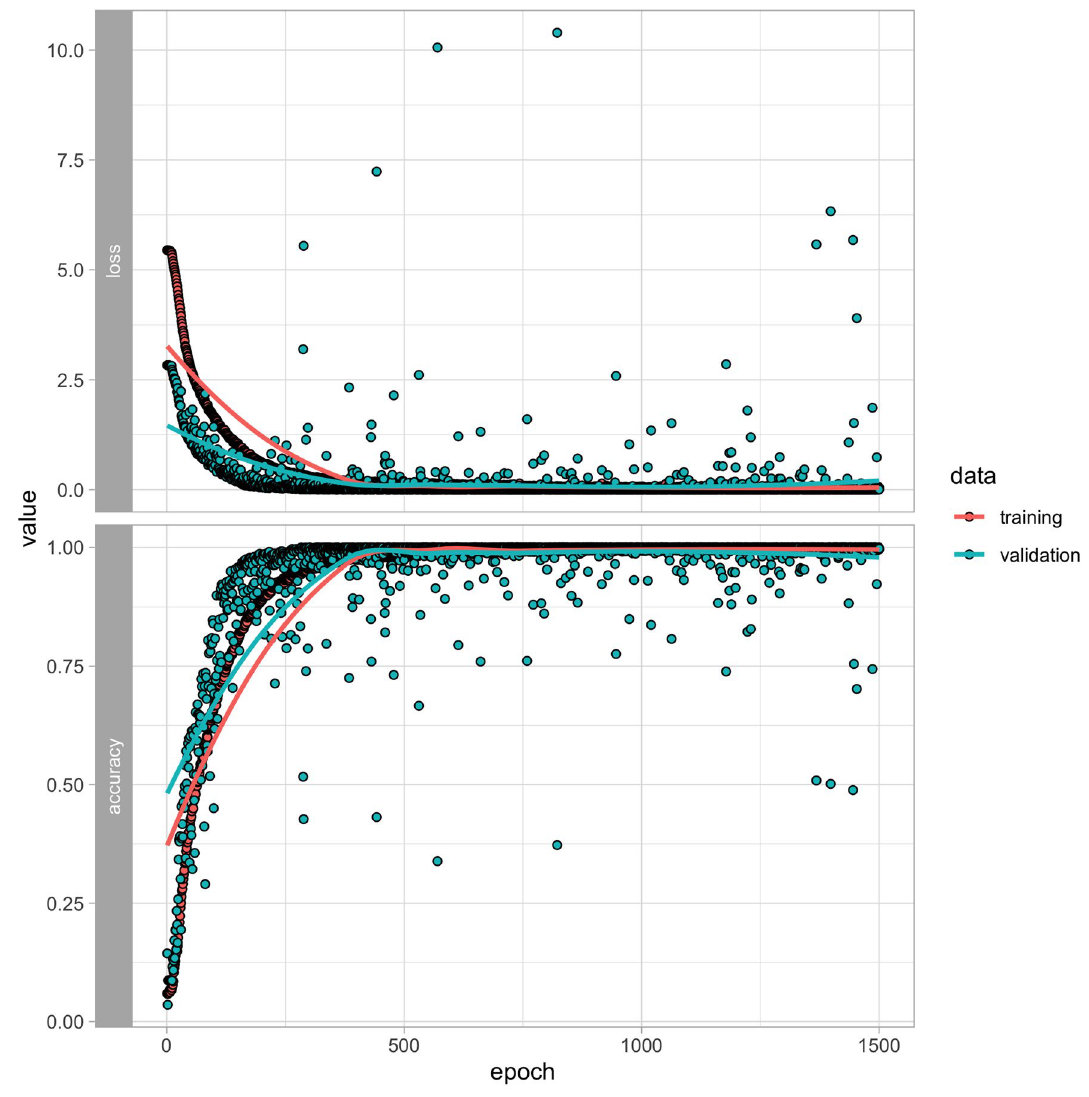
Figure 4. Training and validation loss (top) and accuracy (bottom) for the training (n = 7825) and validation (n = 1382) portions of the repeated dataset. Models converged most of the time after 250 epochs with a smaller range of validation accuracies compared to the full training